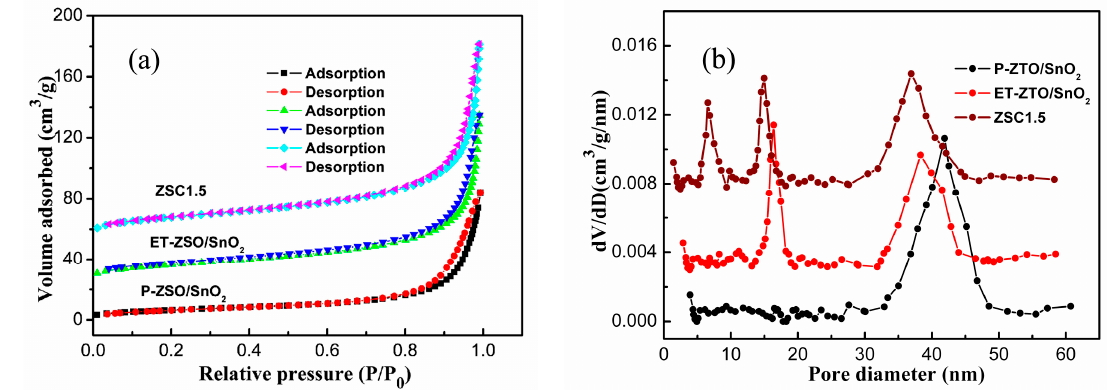
Figure 5. ( a ) The Nitrogen adsorption–desorption isotherm and ( b ) the corresponding pore size and distribution of P-ZSO / SnO 2 , ET-ZSO / SnO 2 and ZSC1.5